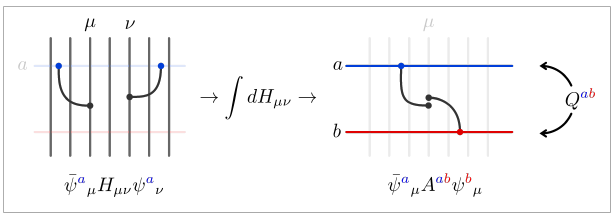
Figure 2: Bulk sigma model: we start from the configuration comprising ‘sea branes’, µ = 1,... L , and spectral branes, a = 1,...4. As a microscopic realization, for